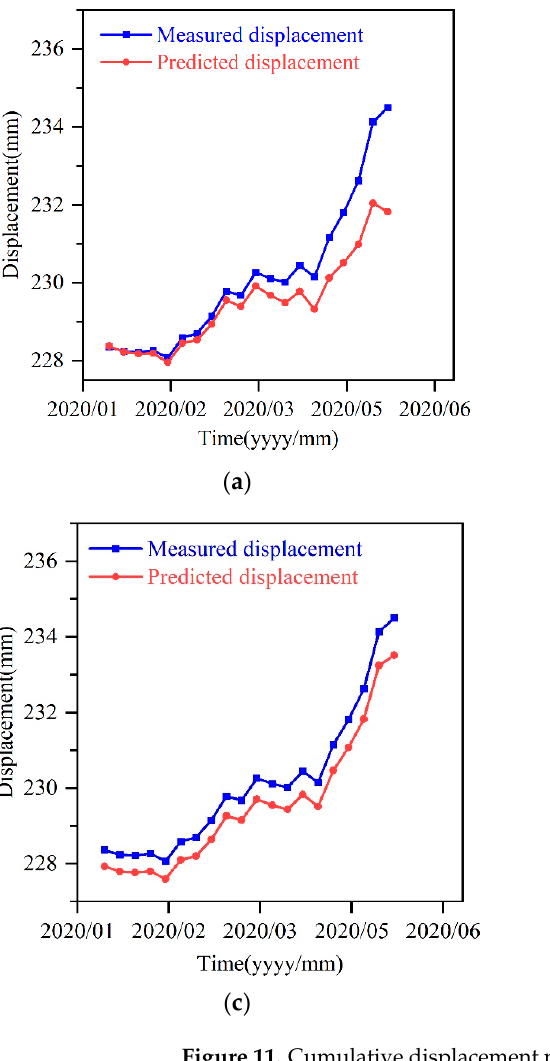
Figure 11. Cumulative displacement prediction results of different training sets: ( a ) prediction results of Model 1; ( b ) prediction results of Model 2; ( c ) prediction results of Model 3; ( d ) prediction results of Model